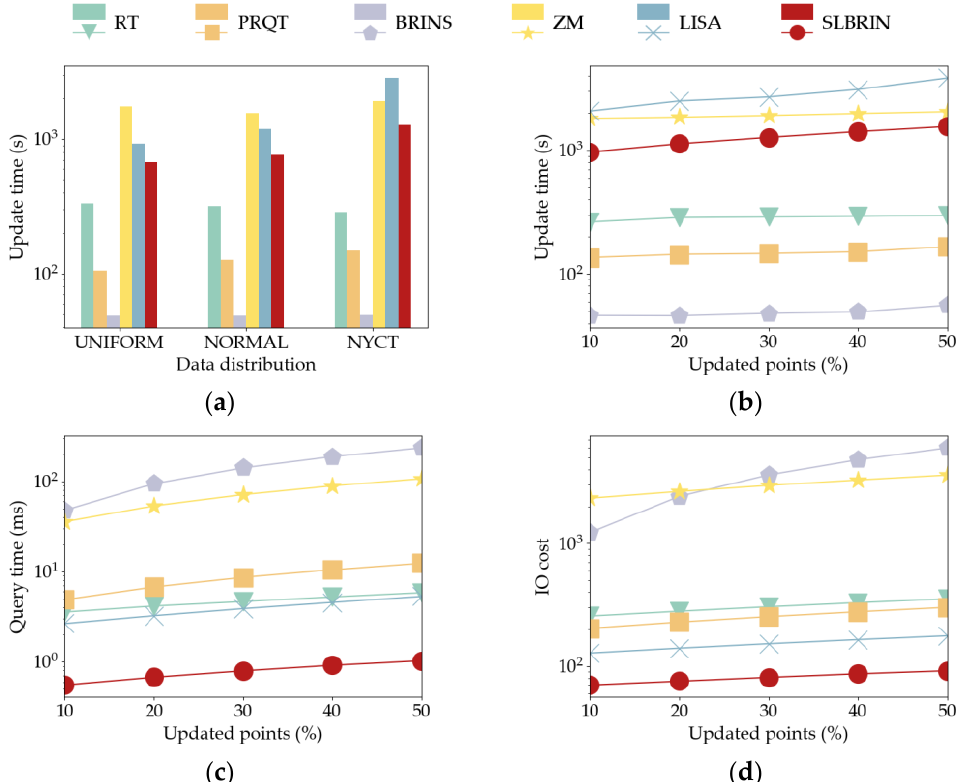
Figure 9. Update performance. ( a , b ) Update time vs. data distribution and updated points. ( c , d ) Range query performance vs. update points.